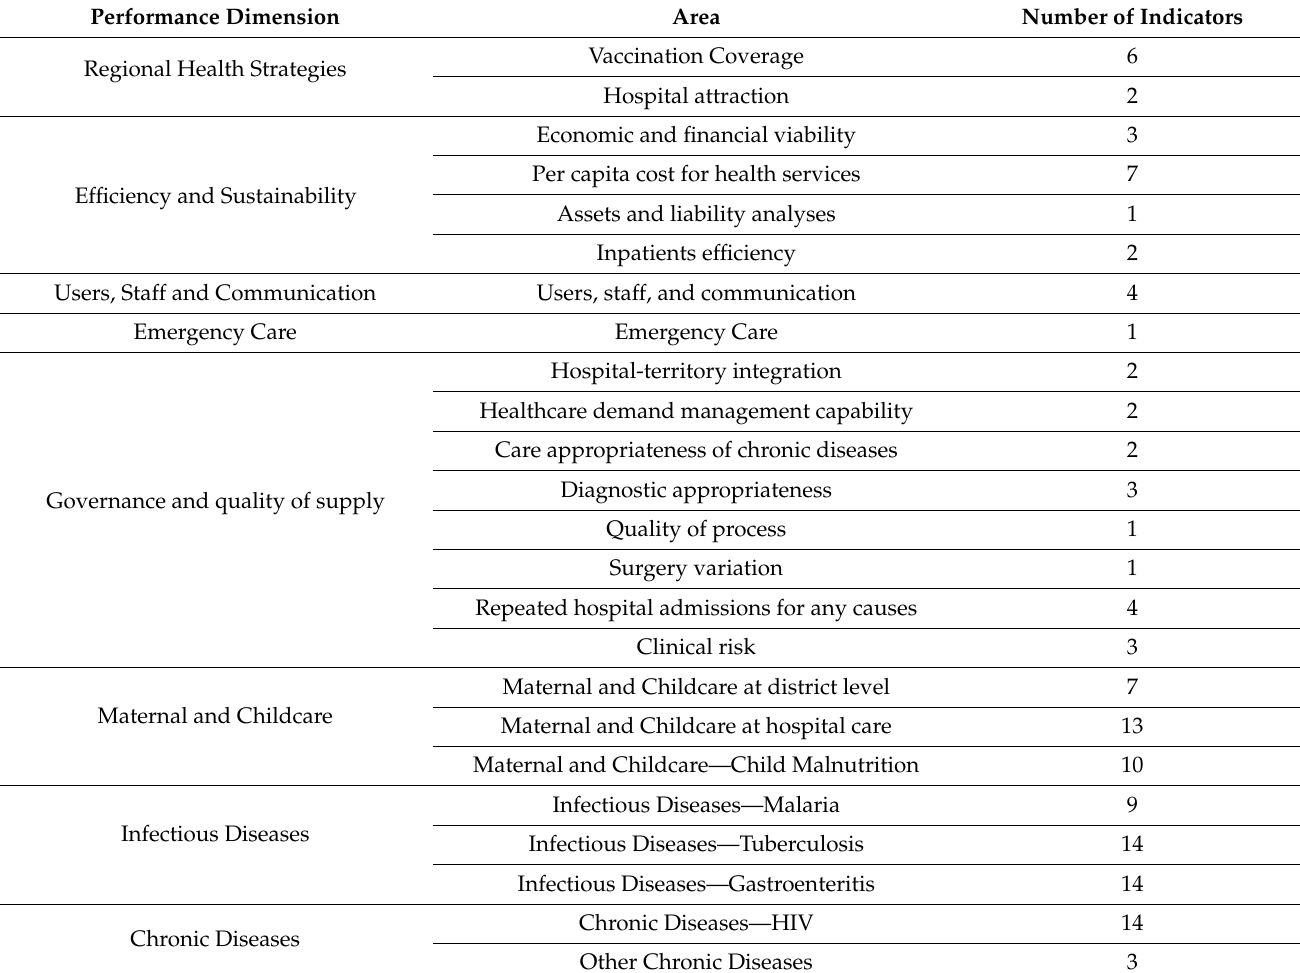
Table 5. Overall map of evaluation dimensions, areas, and